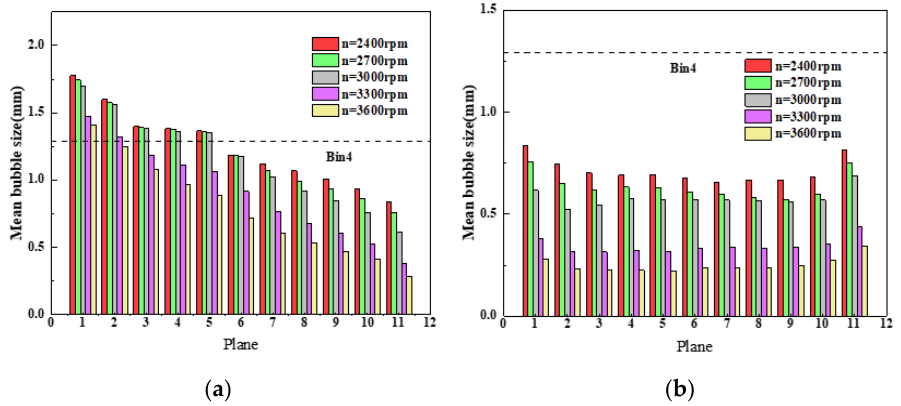
Figure 16. Bubble size distribution in the pressurization unit of the multiphase pump with gas–liquid two-phase media at different rotational speeds. ( a ) Impeller. ( b ) Diffuser.